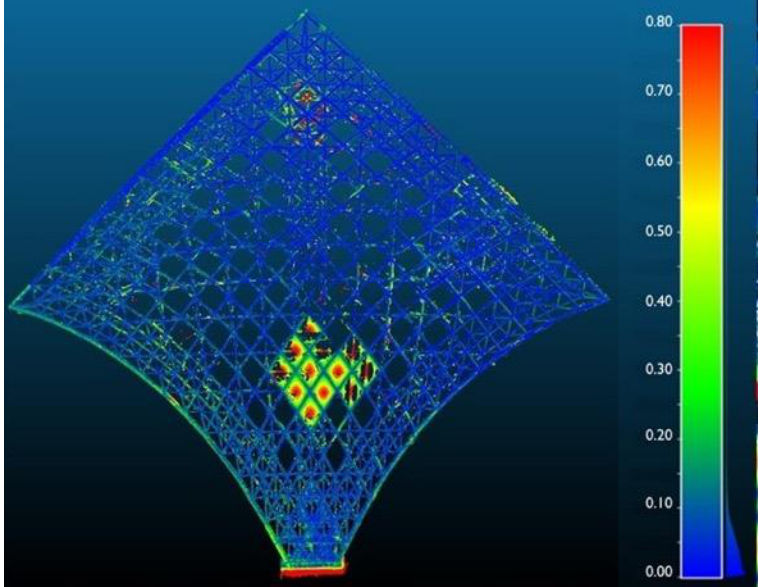
Figure 31. Merging of the two total dense clouds from the TLS and RPAS survey.